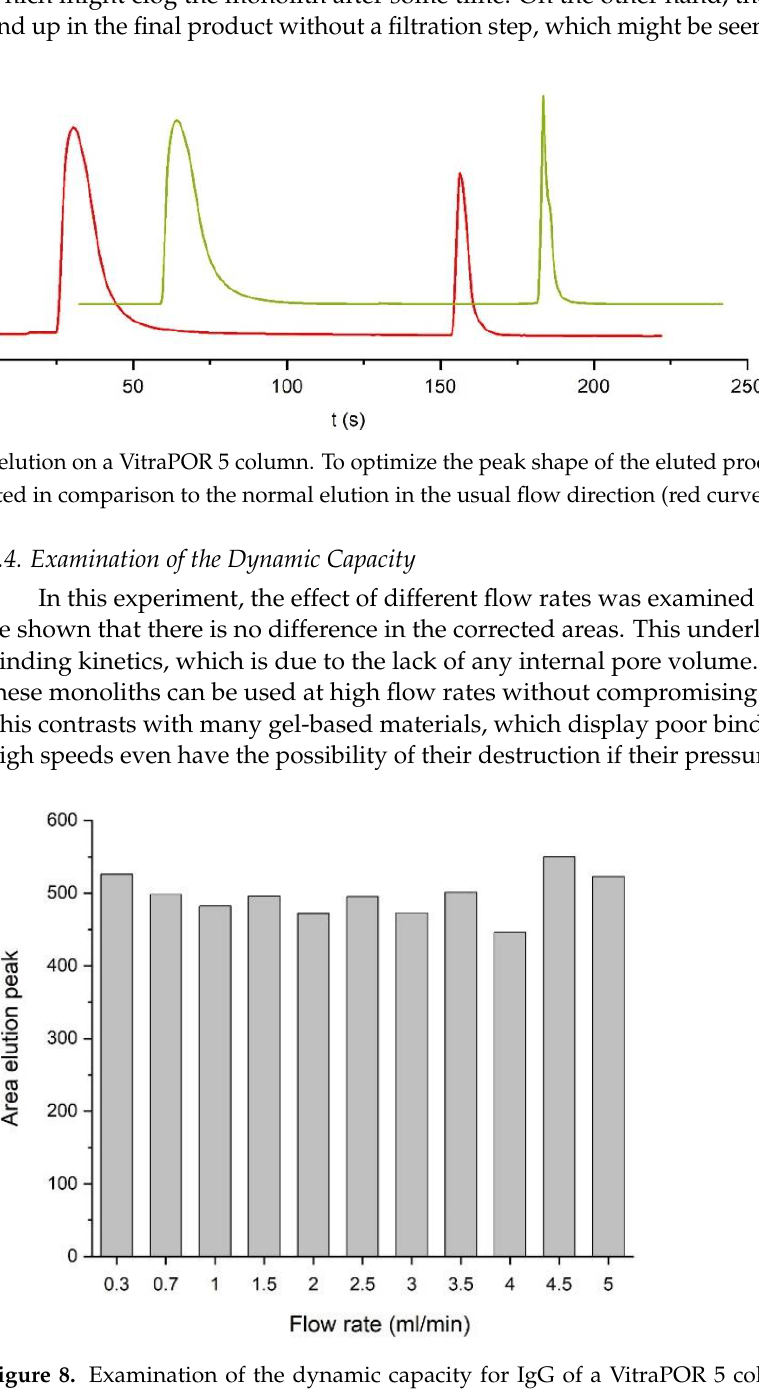
Figure 8. Examination of the dynamic capacity for IgG of a VitraPOR 5 column. The area was corrected for the different flows.